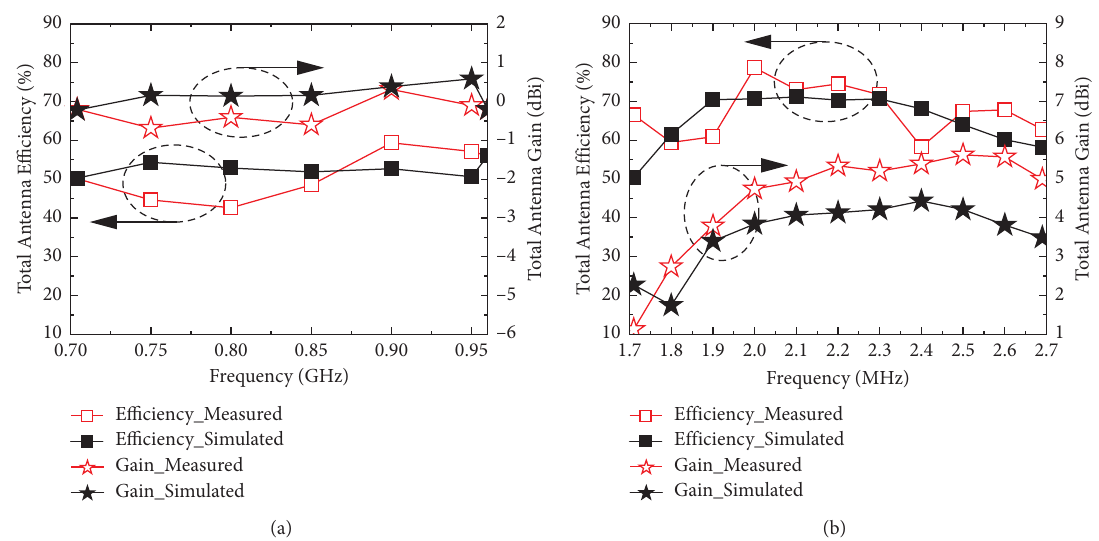
Figure 12: Simulated and measured total antenna gains and efficiencies of the proposed antenna. (a) At the lower frequency band. (b) At the higher frequency